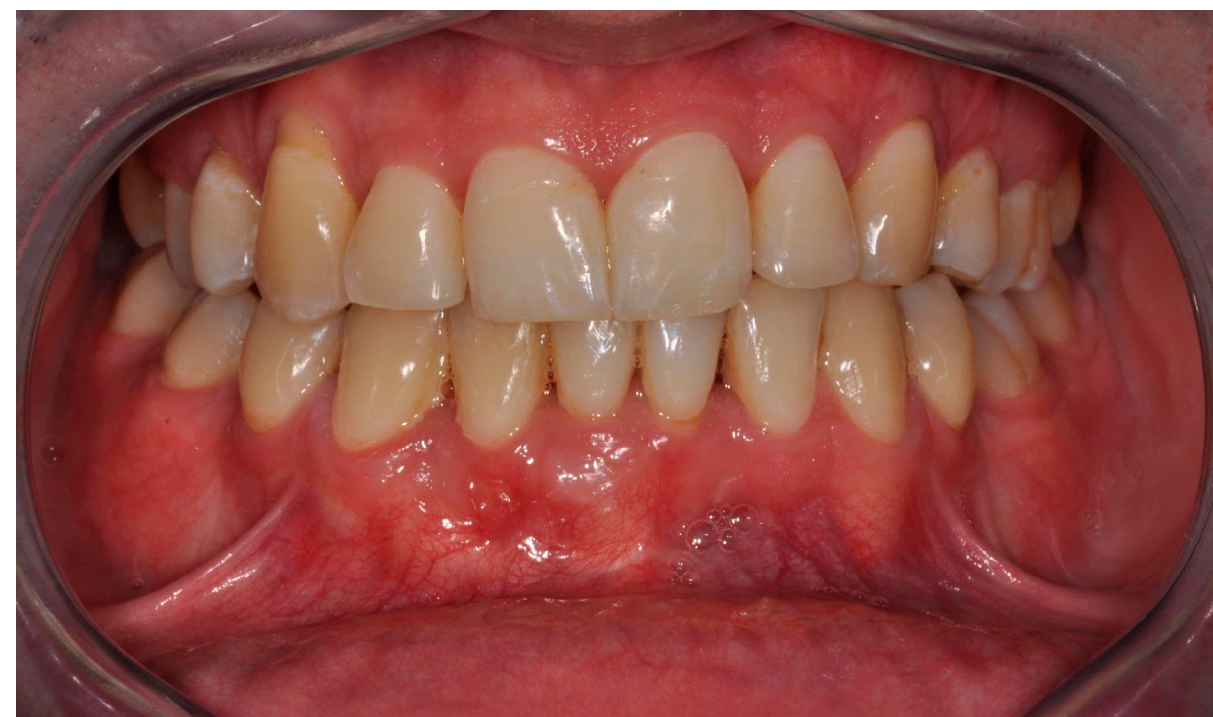
Figure 10. Clinical follow-up picture showing proper occlusion, the adequate amount of keratinized gingiva, effect of gingival recession coverage with the correct vestibule height as well as lack of calculus and advanced alveolar concaves and concavities. There was only a slight reddening of the gingiva in area 42 associated with a small loose bone fragment resulting from the remodeling of the graft.